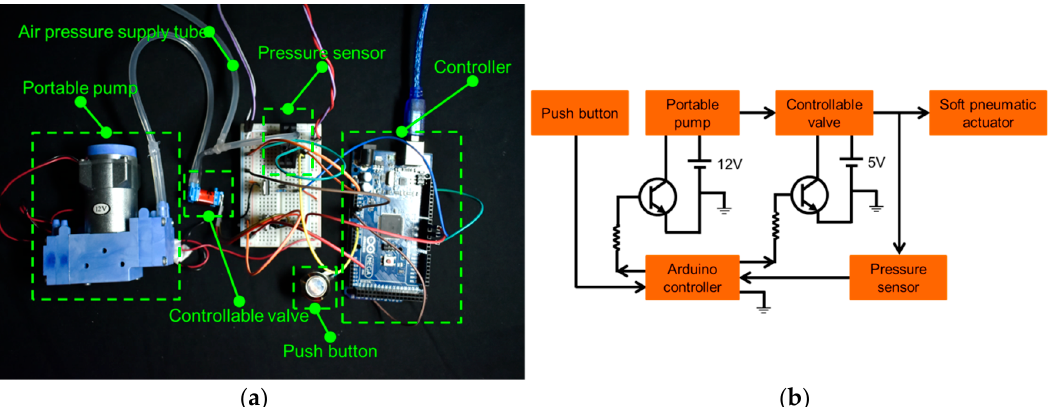
Figure 6. The control system of the soft hybrid surgical gripper: ( a ) the components of the control system; ( b ) the circuit diagram of the control system.